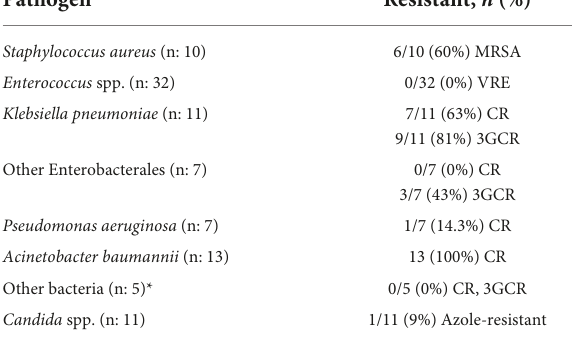
TABLE 6 Pathogens isolated from blood cultures and resistance